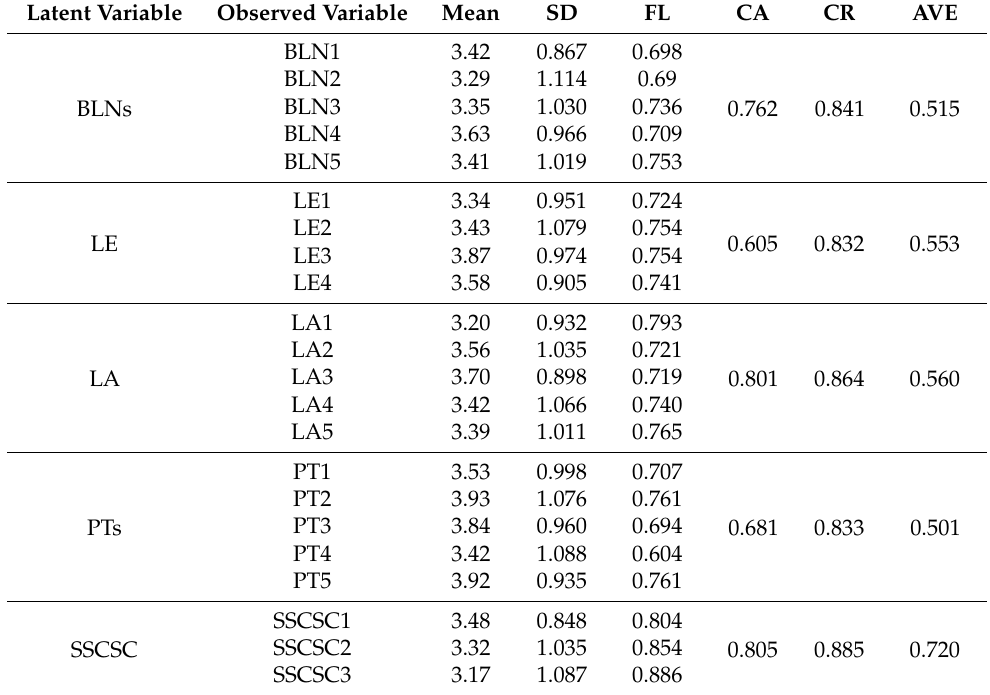
Table 3. Reliability and validity analysis index values.